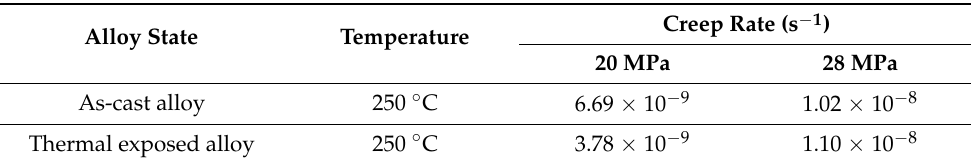
Table 2. Part of the minimum creep rate of Al-Si-Cu-Ni-Mg alloy before and after heat exposure under different creep conditions.